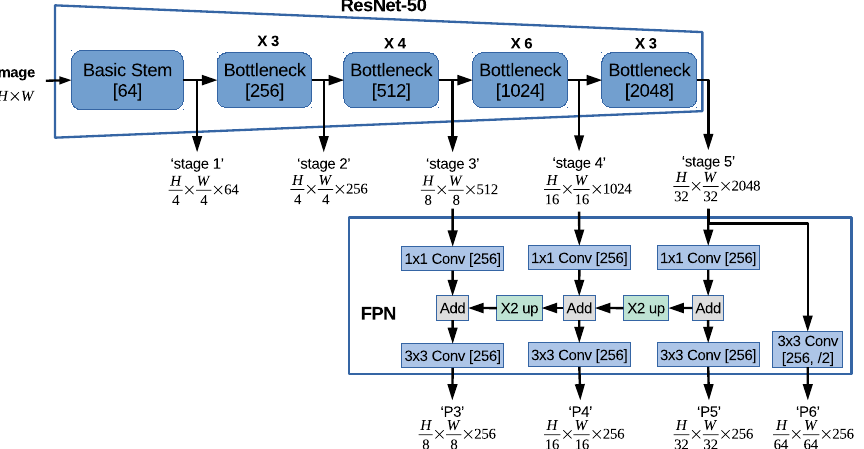
Figure 2. The basic Segment Objects by LOcations (SOLO) combined with You Only Look At CoefficienTs (YOLACT) (SOLACT) architecture employs a ResNet-50-based backbone architecture, which combines the ResNet-50 [12] and FPN [13]